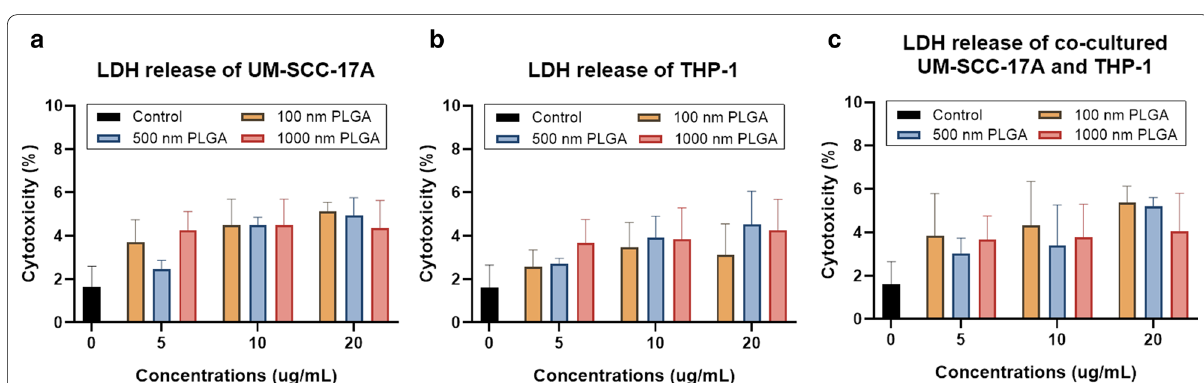
Fig. 3 Determination of cytotoxicity to monoculture and co‑culture cells using the LDH assay. UM‑SCC‑17A ( a ) and THP‑1 cells ( b ), and co‑cultured cells ( c ) were treated with PLGA particles. No significant cell death was observed after 24 h incubation of particles (with different sizes and concentrations used here) and cells in both monoculture and co‑culture